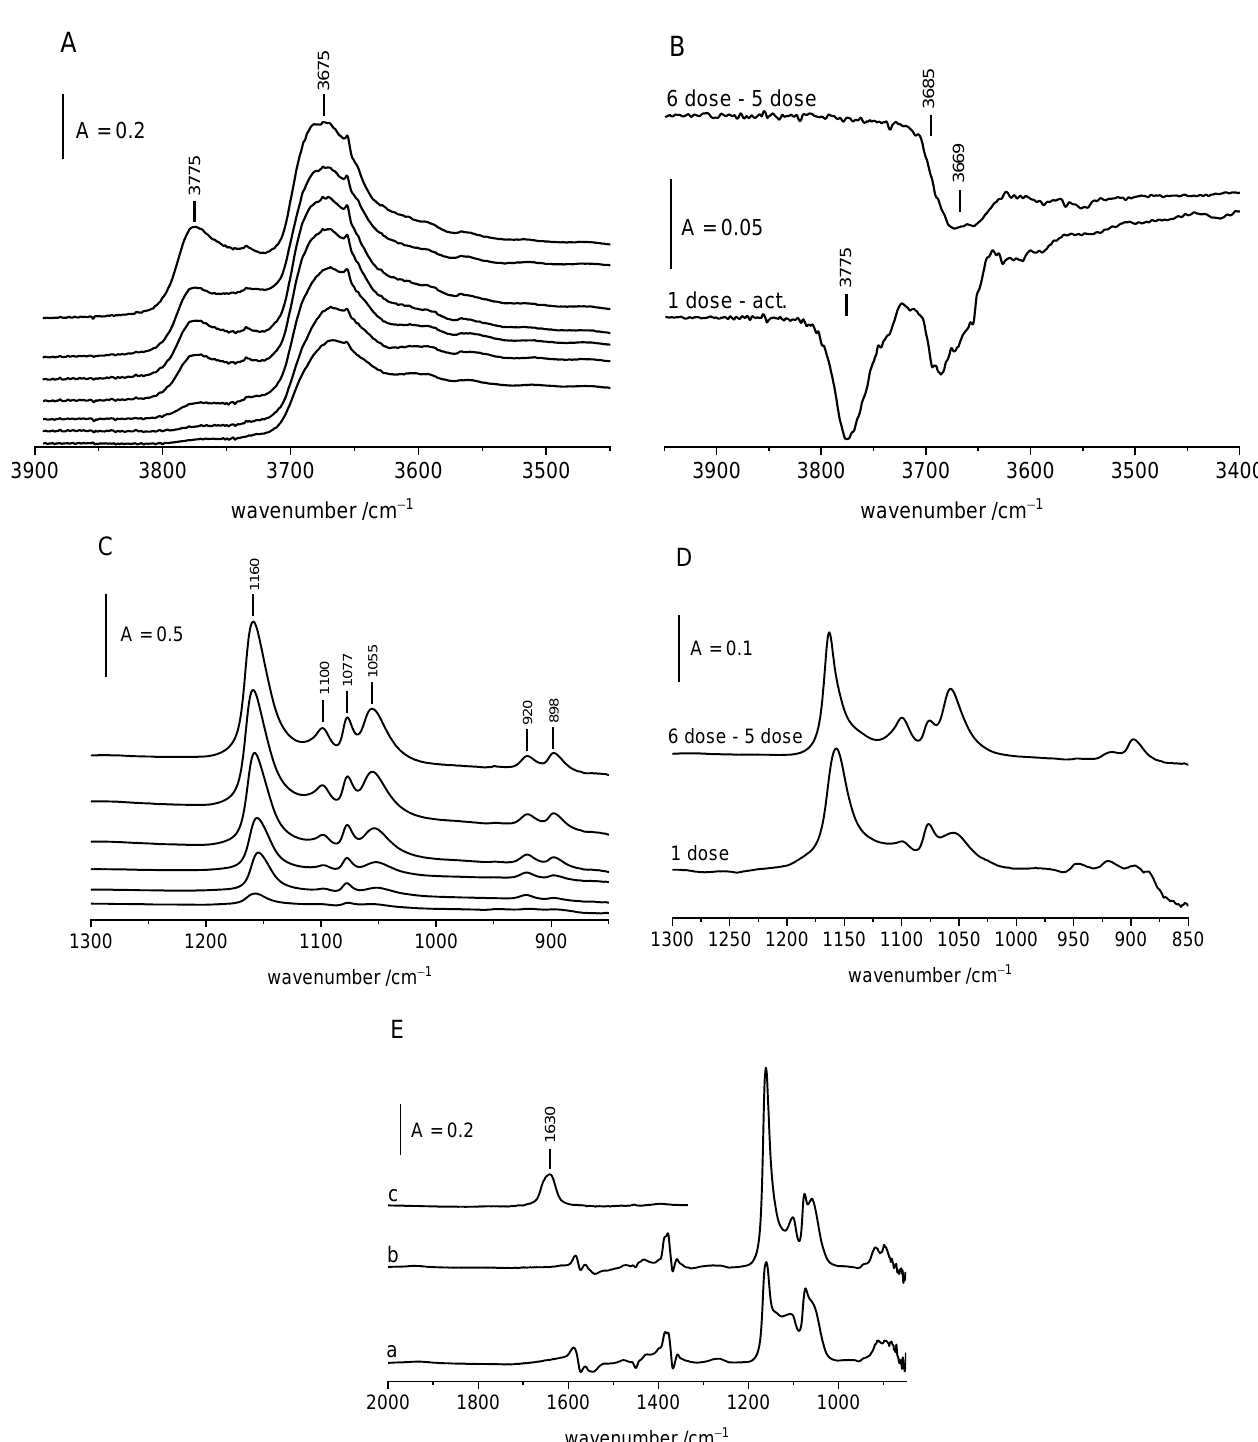
Scheme 1. Monobridged ( A ) and tribridged ( B ) hydroxyl species.